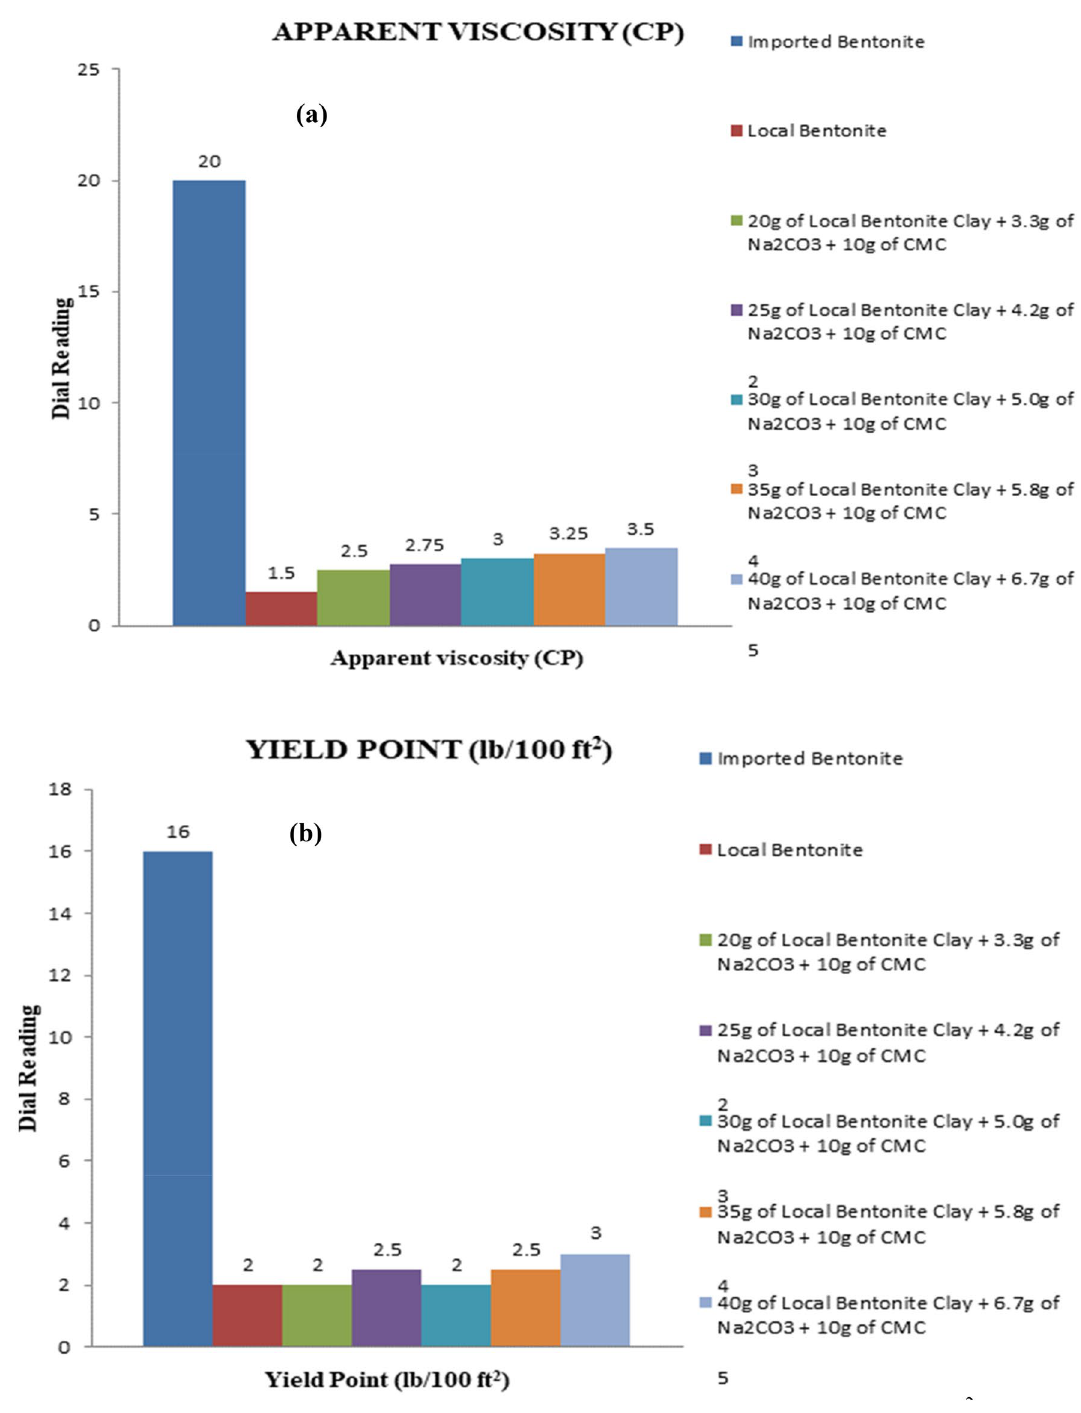
Fig. 11 Histogram showing the Apparent Viscosity ( a ) and the yield point (lb./100 ft 2 ) ( b ) of point shows the capacity of drilling mud to transport cuttings to the surface. Figure 11b shows the comparison between the yield point of the standard bentonite, local bentonite, and the five different samples. From the plot, the different yield point values were obtained subject to the values of viscosity